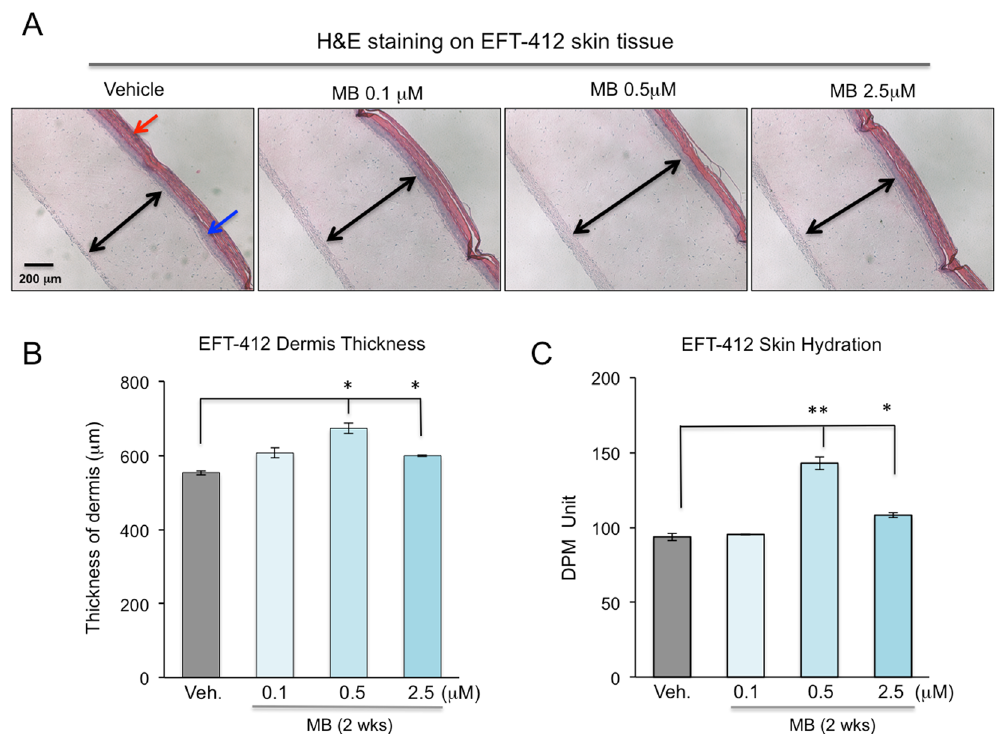
Figure 5. MB increases skin thickness and hydration. ( A ) Representative cross-section images from H&E staining of Epiderm EFT-412 tissues after MB treatment at various concentrations for two weeks. The three skin layers are pointed by colored arrows. Red: the stratum corneum layer, Blue: the keratinocyte layer and black: the dermis fibroblast layer. Scale bar = 200 μ m. ( B ) Histogram plot comparing the thickness of fibroblast layer (black arrows in A ) under different concentrations of MB treatment. The thickness of fibroblast layer was quantified using ImageJ on six consecutive slides for each skin tissue and the average thickness was shown. ( C ) Skin hydration assessed by DPM9003 device showing significantly escalated levels of hydration on the Epiderm EFT-412 skin tissues after two weeks of MB treatment at 0.5 and 2.5 μ M. ( * p < 0.05, ** p <